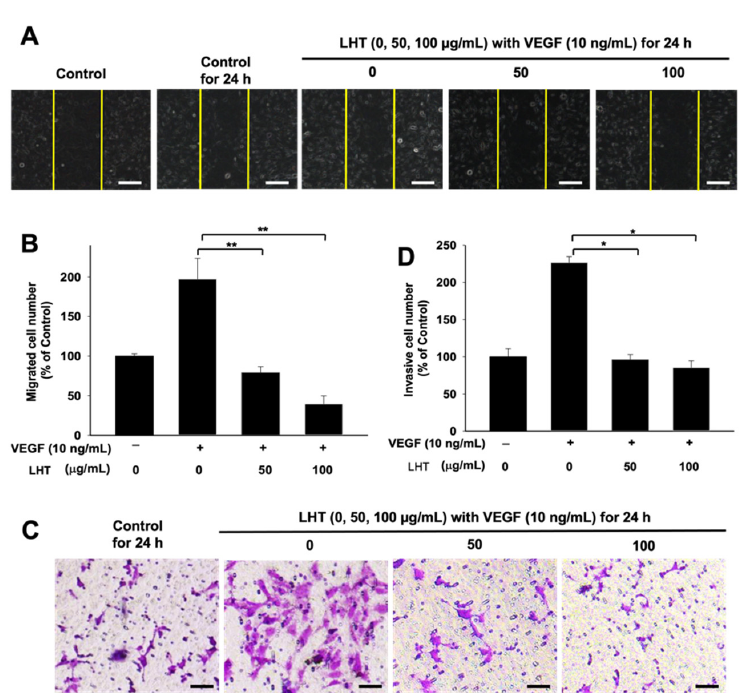
Figure 4. LHT effect on migration and invasion of HUVECs in vitro. ( A ) Optical image of migrating HUVECs into the scratched area after treatment of VEGF (10 ng/mL) or VEGF with LHT (0, 50, 100 µg/mL) for 24 h. Yellow line: scratched area at day 0. Scale bars indicate 200 µm. ( B ) Relative amount of the number of cells migrated into the scratched area, which was compared to that of control group (no treatment of both LHT and VEGF). Data were expressed with mean ± s.e.m. (n = 5). ** p < 0.01 versus the VEGF-treated group. ( C ) Optical image of crystal violet-stained HUVECs invaded through the transwell plate after cultivation with VEGF (10 ng/mL) or VEGF plus LHT (0, 50, 100 µ g/mL) for 24 h. Scale bars indicate 200 µ m. ( D ) Relative amount of the number of crystal violet-stained HUVECs invaded through the transwell plate. Data were expressed with mean ± s.e.m. (n = 5). * p < 0.05 versus the VEGF-treated